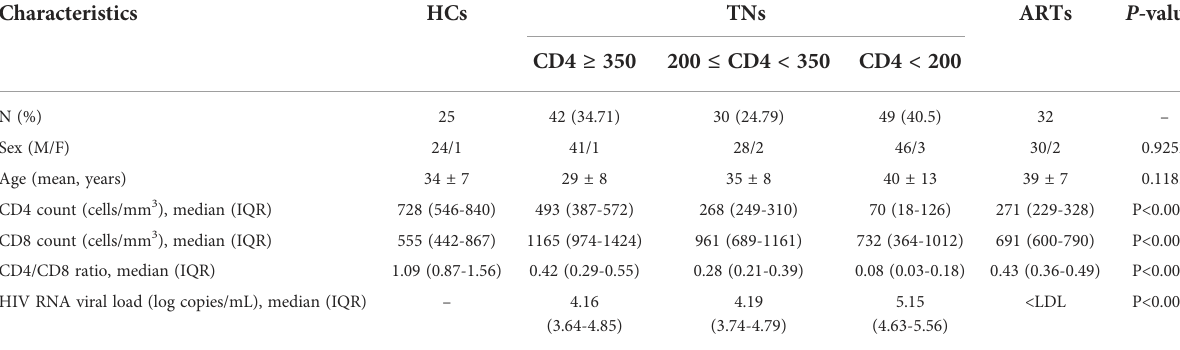
TABLE 1 Demographic and clinical characteristics of study participants.